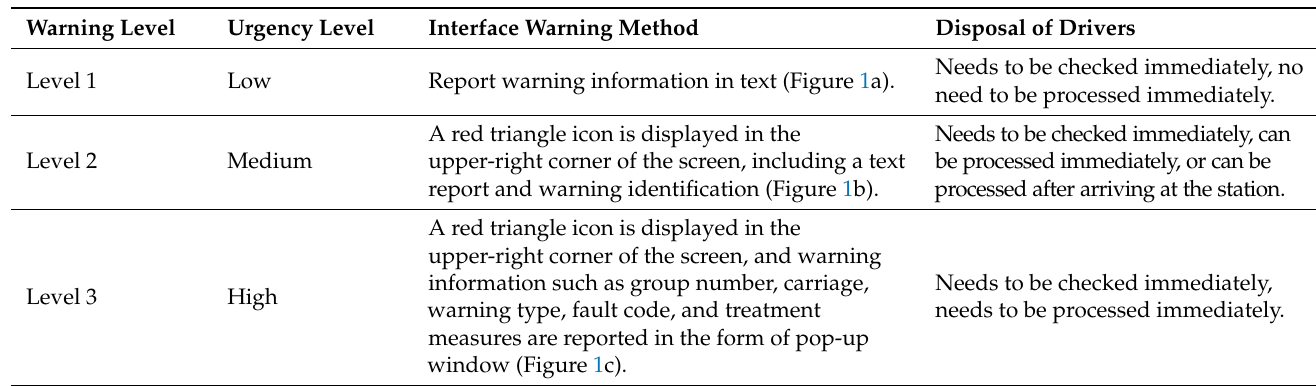
Table 2. High-speed train interface warning